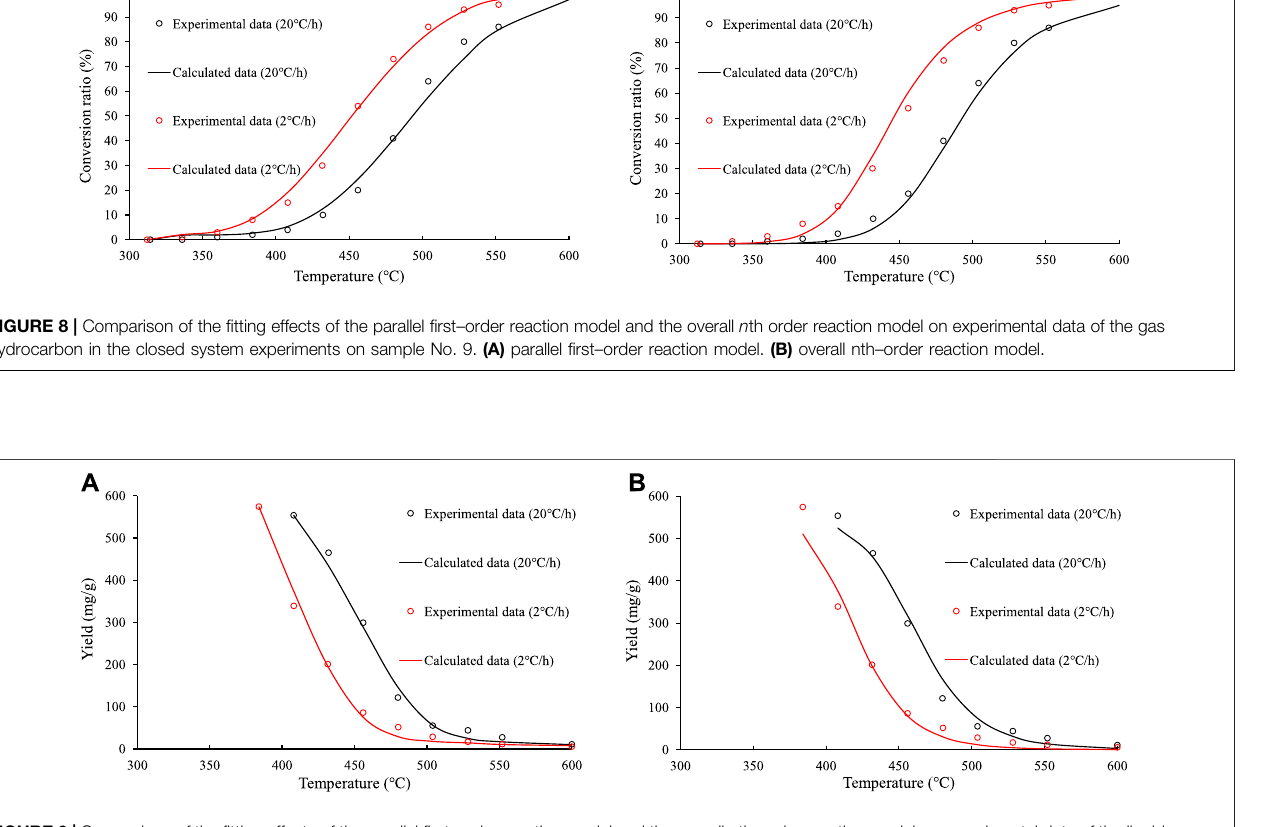
Frontiers in Earth Science |